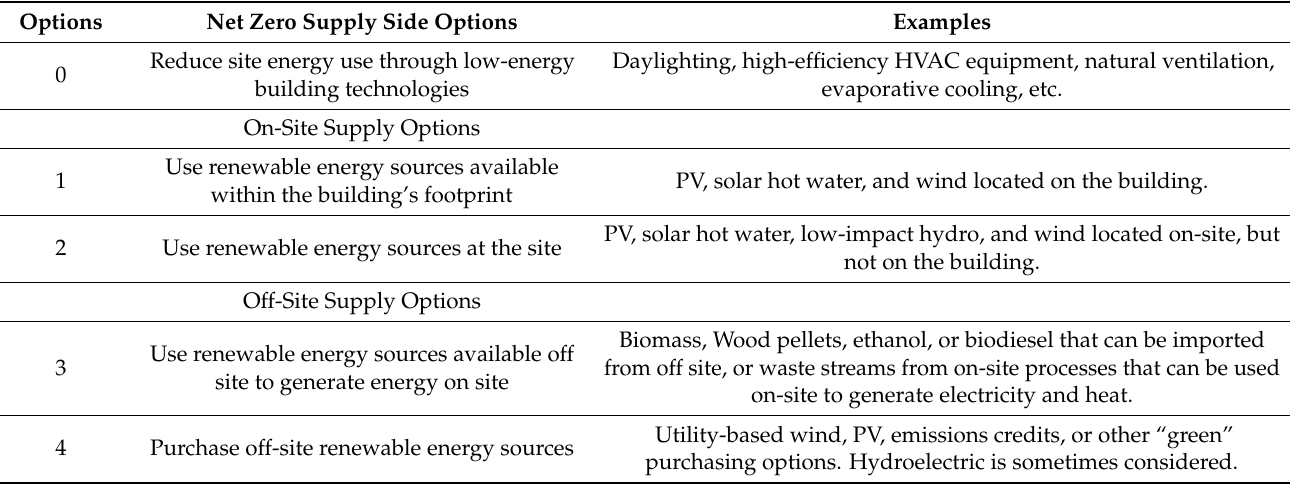
Table 4. Net zero renewable energy supply options, Torcellini et al. [31].